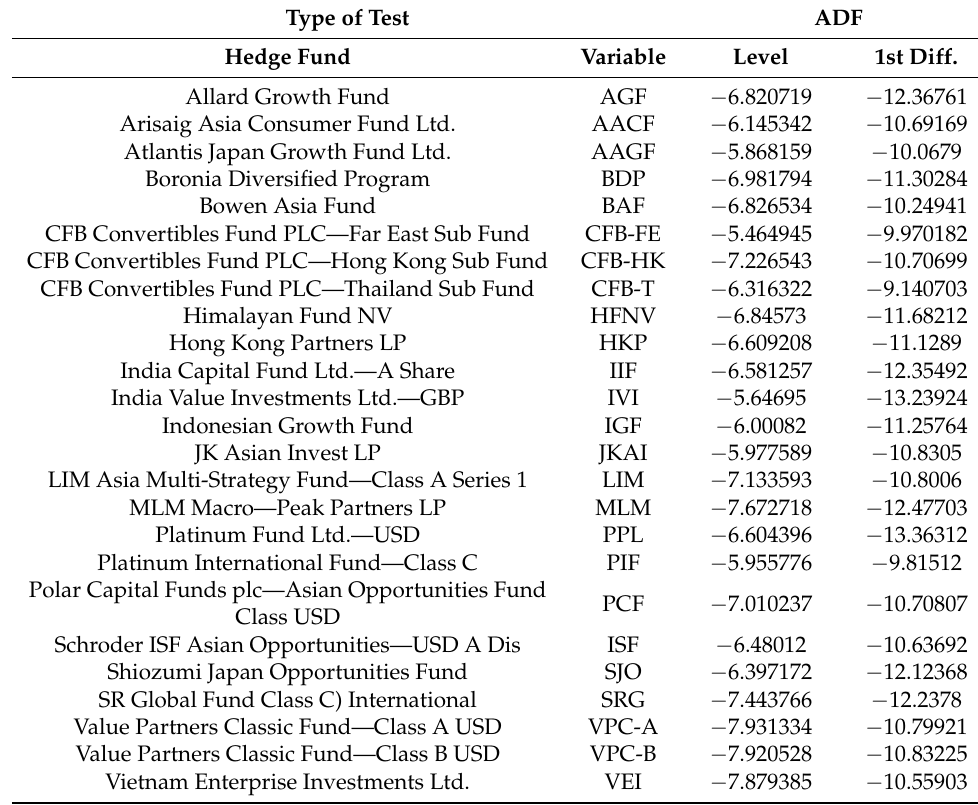
Table A4. ADF Unit Root Test Hedge